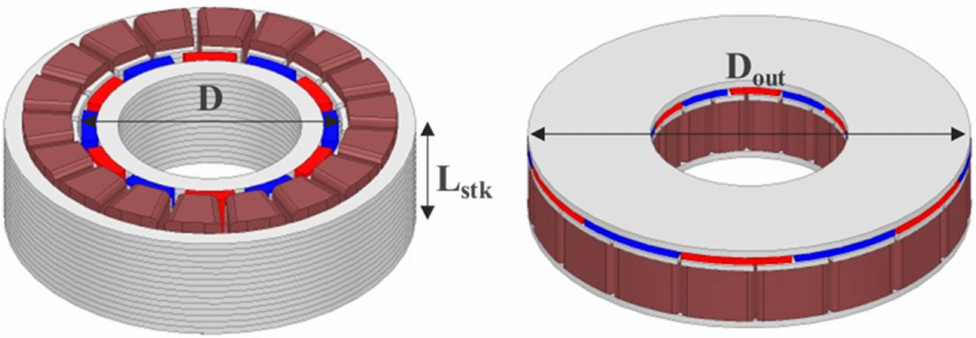
Figure 3. Shape and name of RFPM and AFPM